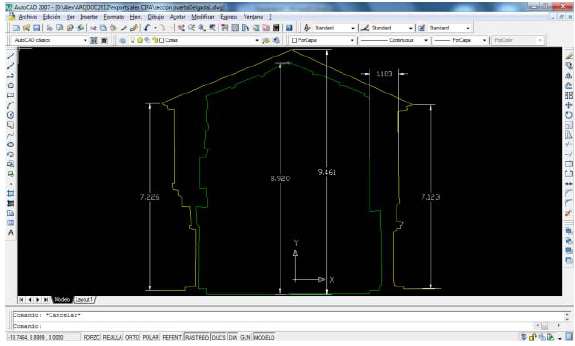
Figure 10. Cross section side view N – S in CAD